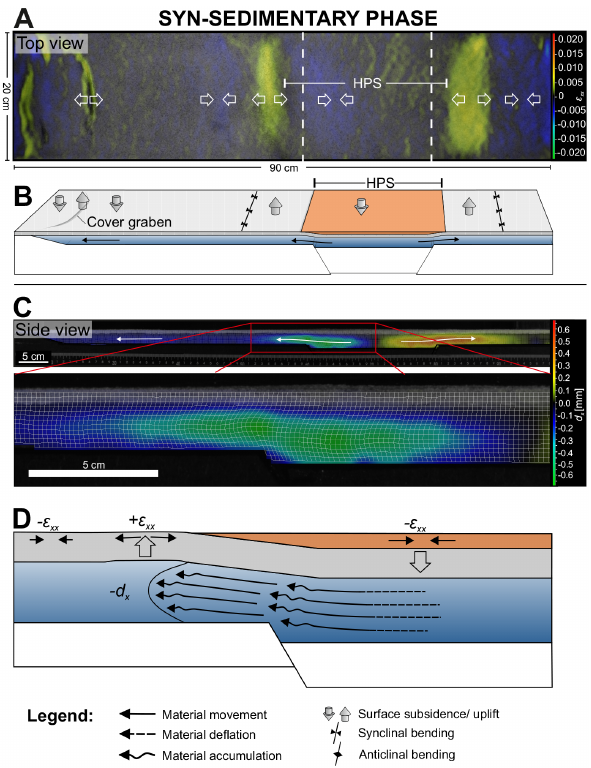
Figure 8. Results of PIV monitoring during syn-sedimentary phase of the reference experiments 1b and Exp. 1c 1h after addition of the first post-extensional sand layer. (a) Top view of Exp. 1c: lateral strain ε xx observed with PIV displaying zones of extension (yel- low) and zones of compression (blue). Dashed lines indicate loca- tion of basal faults. HPS = hanging wall peripheral sink. (b) Sketch showing the interpretation of the PIV strain patterns. (c) Side view of Exp. 1b: horizontal displacement d x observed with PIV includ- ing a detailed view of the left basement fault. Coloured areas dis- play rightward (yellow–red) and leftward (green–blue) movement of the analogue material. (d) Conceptual sketch (arrows are not to scale) summarizing the interpreted displacement patterns and show- ing representative vector profiles of the material